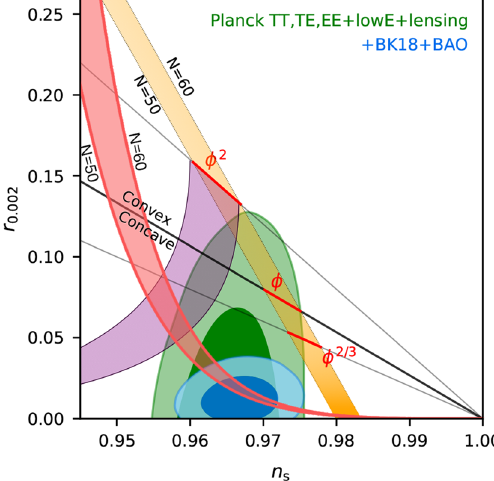
Fig. 2 On the Figure 5 of Ref. [67], the upper limit (6.9) is plotted for χ = 10 − 3 . The red zone bound by the e -folding number N 50 , 60 curvesagreeswiththeblueconstraintzone.Theconstraintonthe tensor-to-scalar ratio r also agrees with the upper limit r < 0 . 044 from therecentobservation[68].TheFigure5ofRef.[67]comesfromFigure 28 of Ref. [69] and Figure 8 of Ref. [66]. Their figure captions indicate inflation models studied. For example, the yellow region shows the loci of approximately constant e -folding number N , assuming simple V (φ) ∝ (φ/ m pl ) p single-fieldinflation.Itshowsthattheredzoneofthe ˜ (cid:2) CDM is distinct from the constrained zones of other inflation